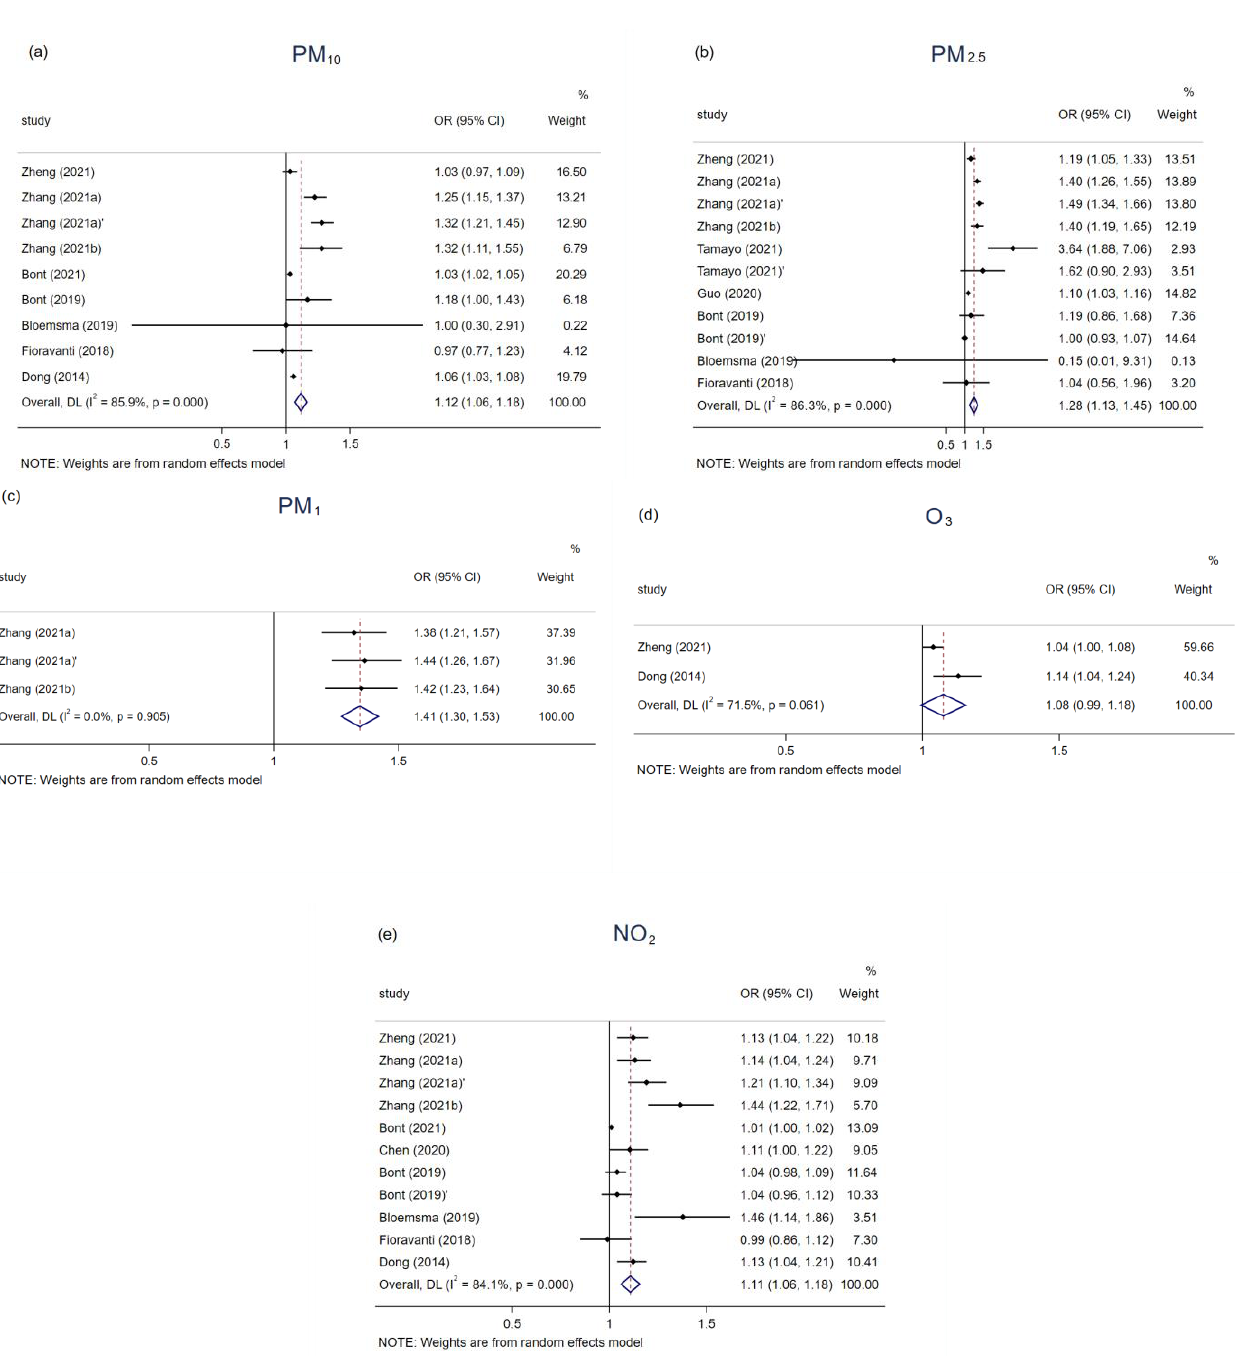
Figure 2. Associations of PM 10 ( a ), PM 2.5 ( b ), PM 1 ( c ), O 3 ( d ), and NO 2 ( e ) with obesity in children and adolescents.